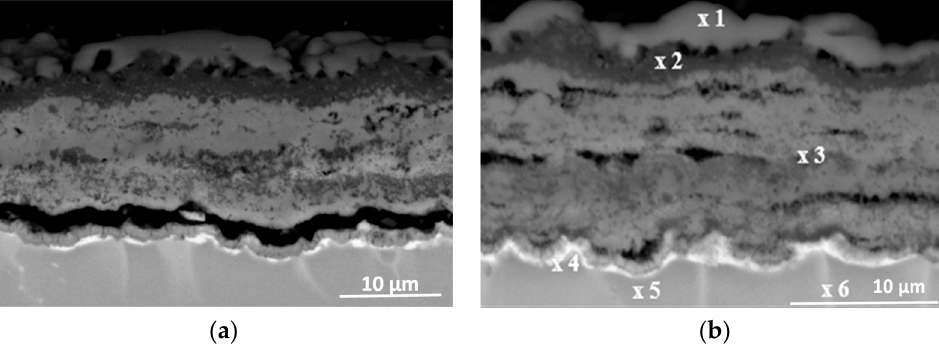
Figure 15. SEM-BSE images of Ti–46Al–7Nb–0.7Cr–0.1Si–0.2Ni alloy after cyclic oxidation at ( a ) 925 °C; ( b ) 950 °C (surface prepared by grinding) [26]. The banded contrast between the product layer and the metallic substrate is an incen- tive to check whether the chemical composition of the different sublayers was affected by the temperature increase. To this end, microanalyses were performed at multiple points in the layer (Figure 16, Table 3). Table 3. EDS analysis results in points marked in Figure 15 (mean values and standard deviations).